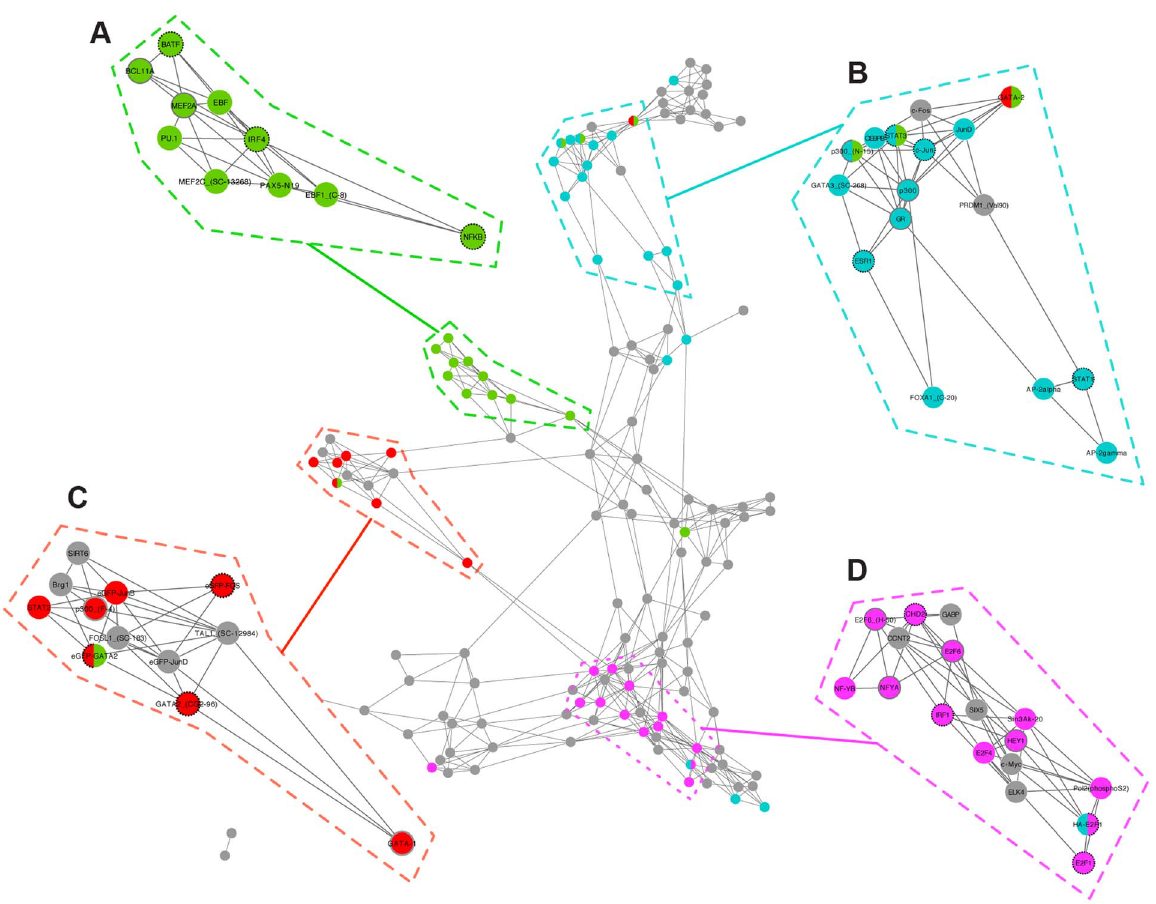
Figure 4. Transcription factor interaction network reveals functional and disease sub-networks. Transcription factors are connected solely on the basis of the similarity of the modules that they regulate. Transcription factors are colored according to a selection of diseases; (A, green): AIDS; (B, blue): arrhythmia; (C, pink): breast cancer; (D, red): hemorrhage. Nodes are annotated with strong (dashed black borders) and weak (solid grey borders) literature support. See Table 2 for details.